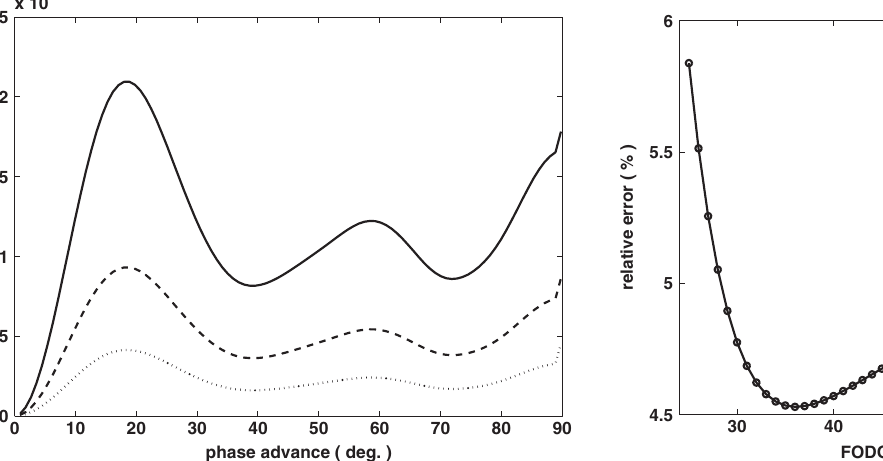
FIG. 5. Condition number of M phase advance for (cid:6) -function 90 m (solid line), 60 m (dashed), and 40 m (dotted line). 5 wire scanners.